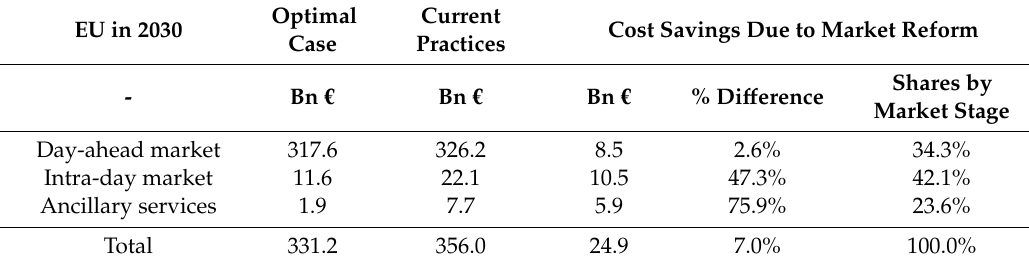
Table 3. Total costs (and payments) in the EU power